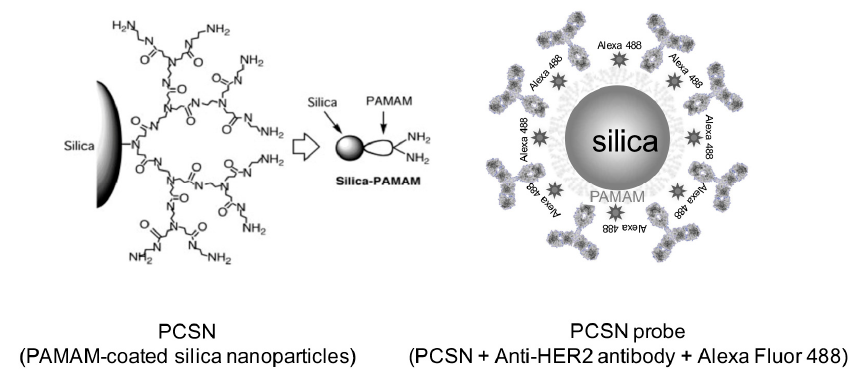
Figure 13. PCSN: Hyperbranched polyamidoamine (PAMAM) is grafted onto the surface of an amorphous silica nanoparticle to functionalize the particle. PCSN probe: PCSN is conjugated with a fluorescent dye, Alexa Fluor 488, and anti-HER2 antibodies are covalently attached to the labeled PCSN.